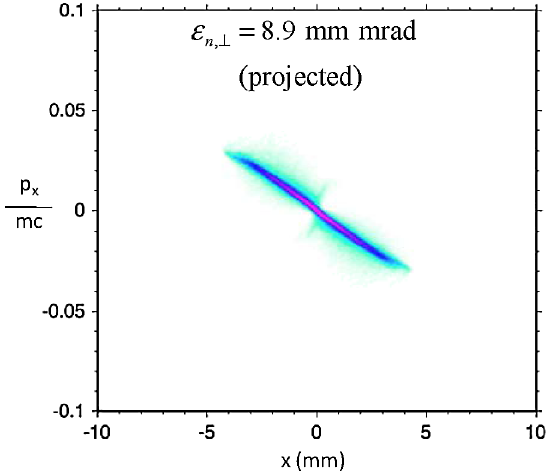
FIG. 12. Projected transverse phase space for the gun geome- try of Fig. 9. The ordinate is the x component of the momentum normalized to mc and the abscissa is the x coordinate. The projected normalized emittance is " n; ? ¼ 8 : 9 mm mrad .